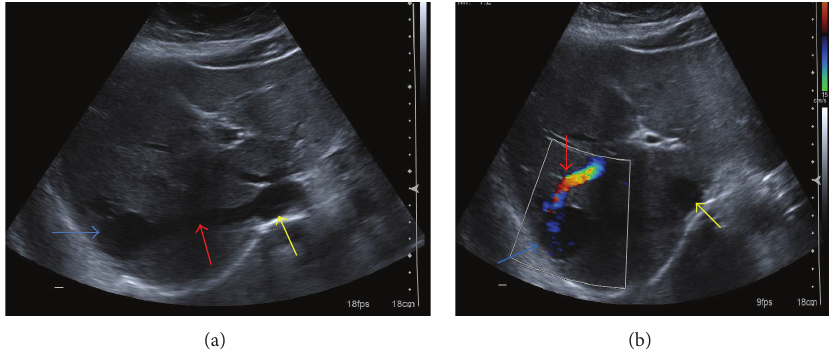
Figure 1: A 45-year-old female with congenital intrahepatic portosystemic venous shunts with associated aneurysms. (a) US image shows an abnormal communication between the right hepatic vein (red arrow) and right portal vein through an aneurysm (blue arrow). Inferior vena cava (yellow arrow) is also seen. (b) Color Doppler US image demonstrates the communication of the right portal vein (red arrow) to the right hepatic vein (not shown) through an aneurysm (blue arrow) within segment VII of the liver. Color Doppler reveals flow within the right portal vein (red arrow) and the aneurysm (blue arrow). Inferior vena cava (yellow arrow) is also seen. Technique: curvilinear 1–4.5 MHz transducer performed on a Siemens Acuson S3000 ultrasound machine.